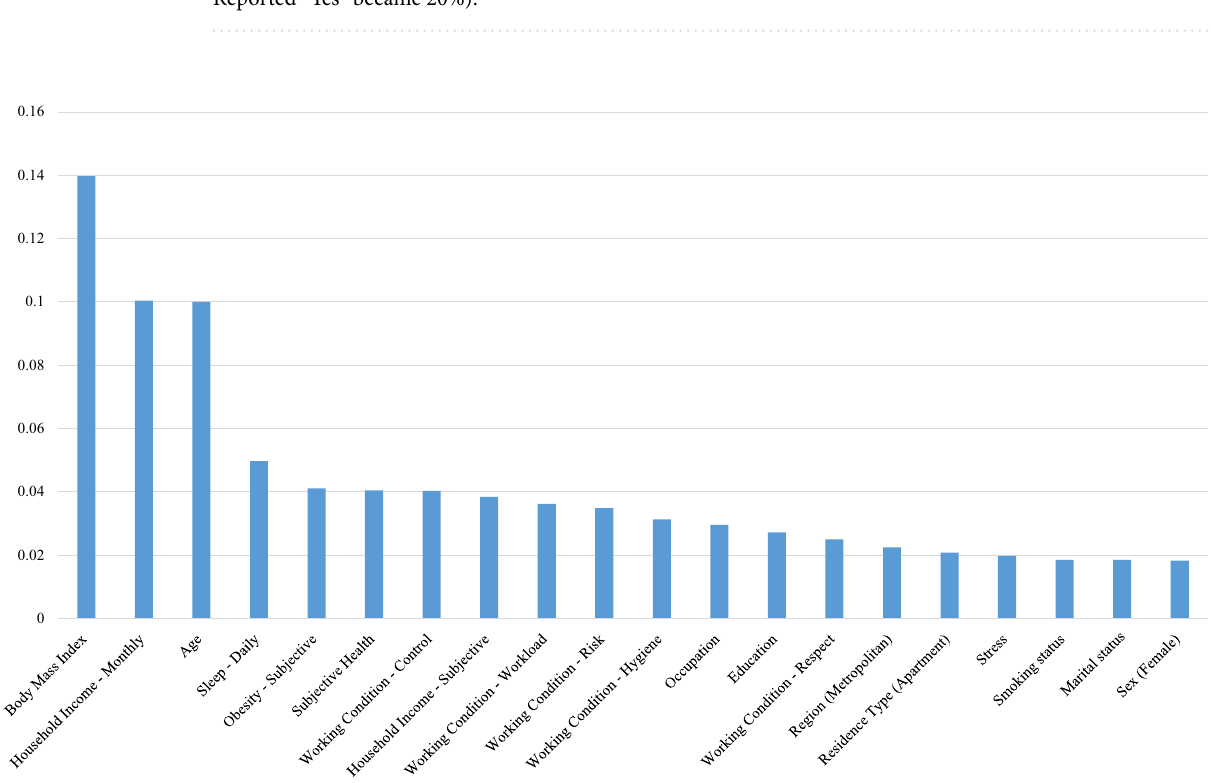
Figure 1. Based on variable importance from the random forest, the top 20 determinants of self-reported TMDs were body mass index, household income (monthly), age, sleep (daily), obesity (subjective), subjective health, working conditions (control, hygiene, respect, risks, and workload), subjective household income, occupation, education, region (metropolitan), residence type (apartment), stress, smoking status, marital status, and